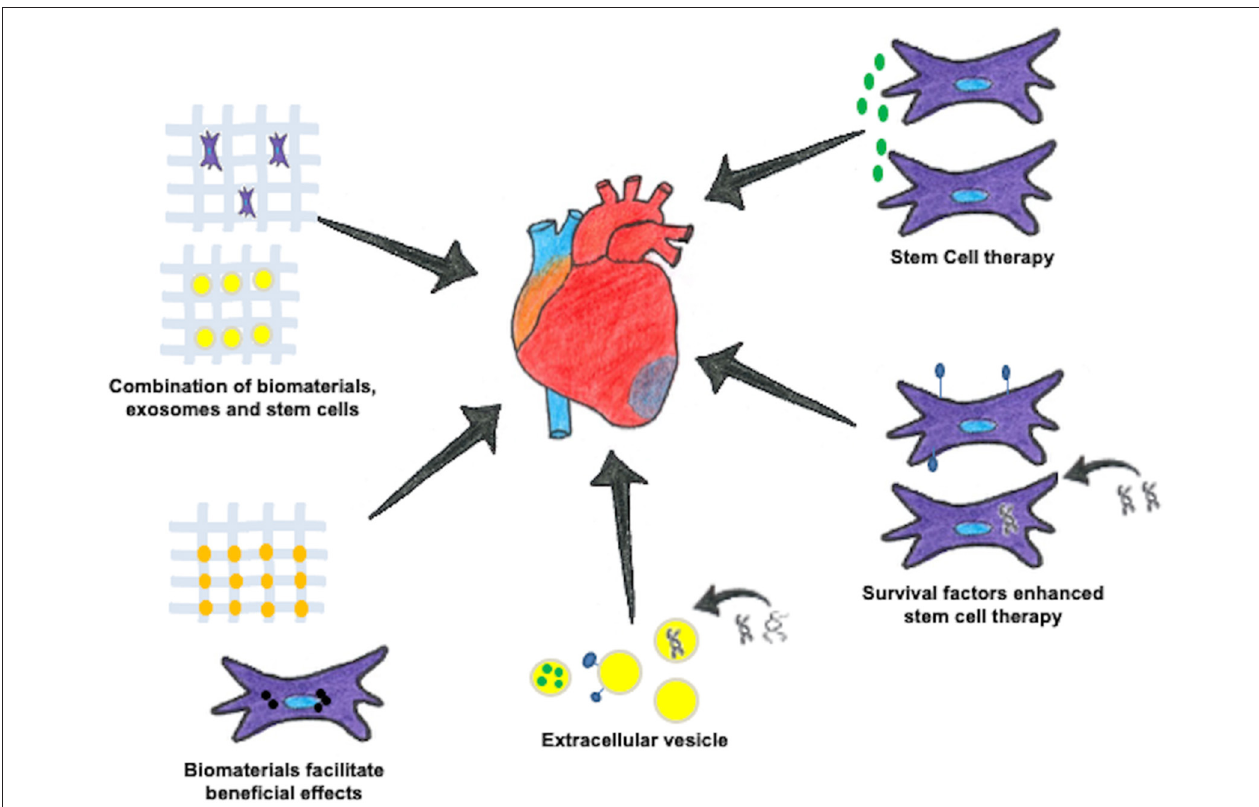
FIGURE 1 | Different approaches for cardiac regeneration. Cell therapy using stem cells can help treat the damaged myocardium. These stem cells enriched with different biomolecules can exhibit positive effects on the heart muscle. The extracellular vesicles released from stem cells have also emerged as excellent source of therapeutic agents. Using specially engineered biomaterials aids in creating a 3D microenvironment which can be injected alone or in combination with stem